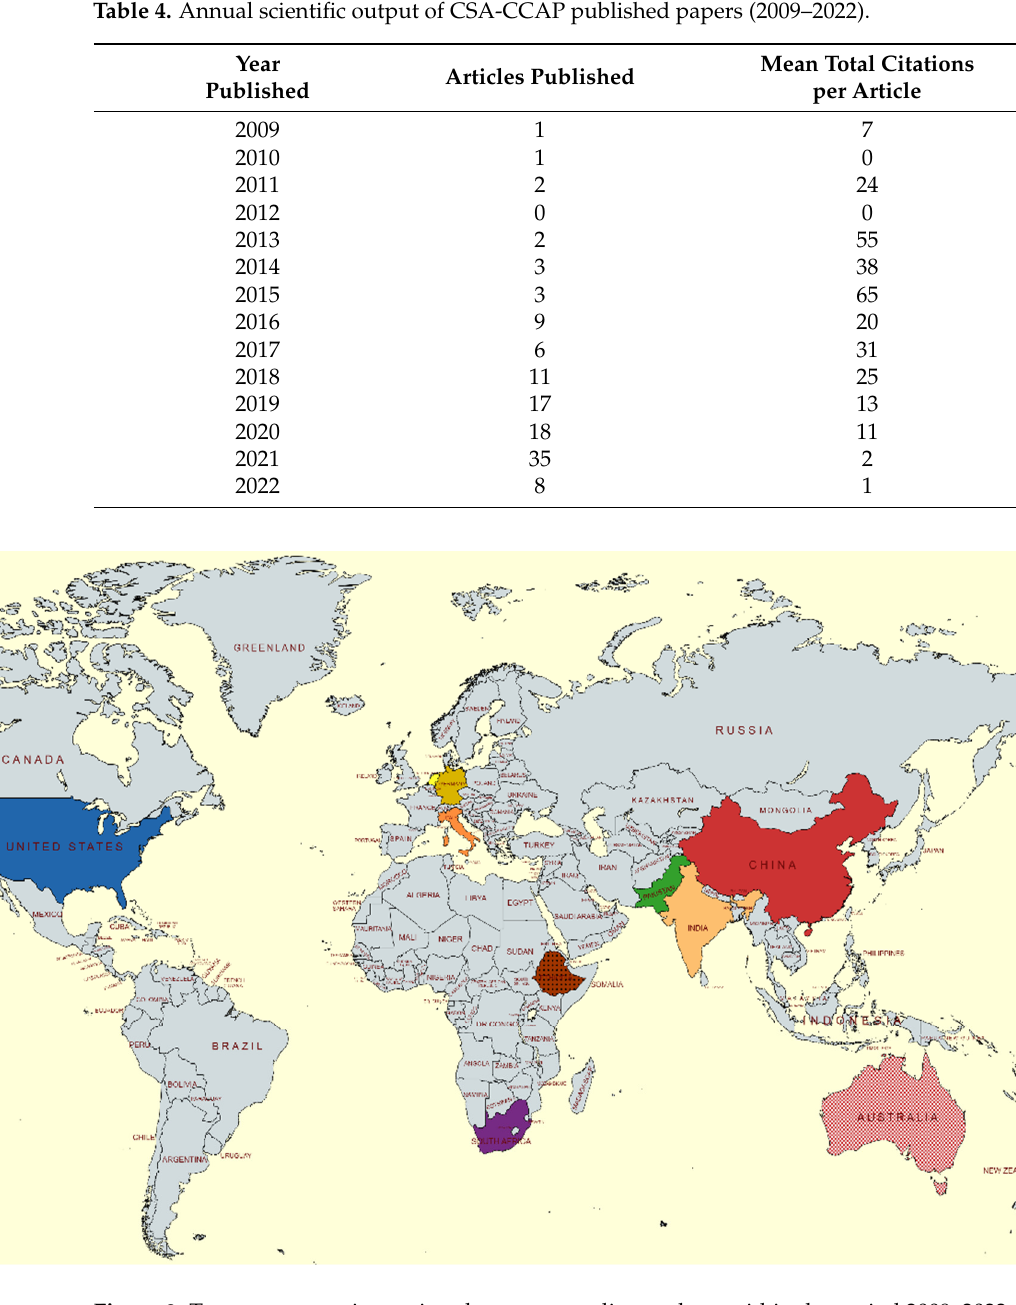
Table 4. Annual scientific output of CSA-CCAP published papers (2009–2022).